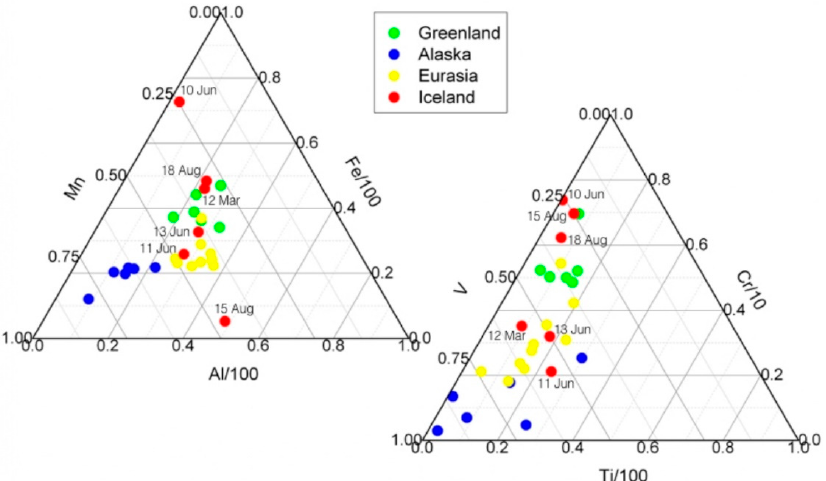
Figure 3. Patterns of the geochemical markers of the dust source regions.